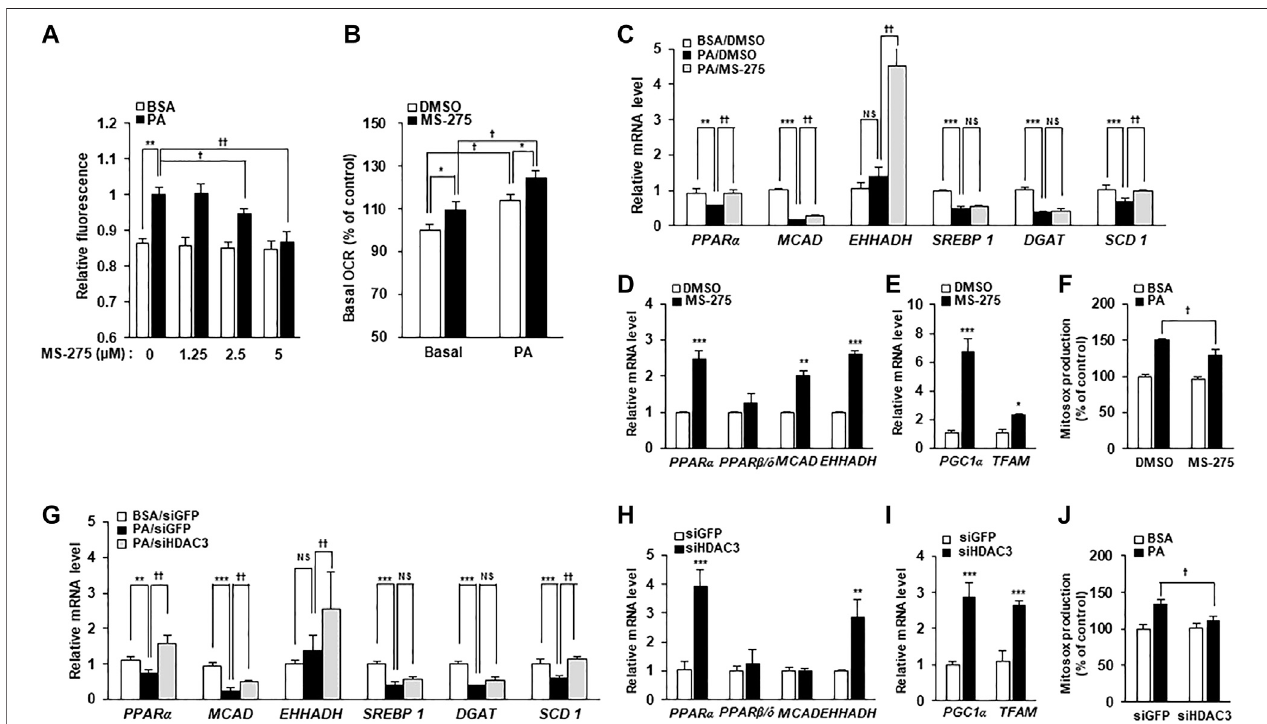
FIGURE 5 | Inhibition of HDAC3 by MS-275 or siRNA increased mitochondrial fatty acid oxidation and related gene expression. (A) C2C12 myotubes were pretreated with various concentrations of MS-275 for 16 h and then treated with 300 μ M PA for 6 h. The intracellular TG content was determined by measuring the fl uorescence of BODIPY. ** p < 0.01 vs. PA-untreated cells, † p < 0.05; †† p < 0.01 vs. PA-treated cells. (B) The OCR of PA when used as the sole carbon substrate was measuredusingtheSeahorseXFAnalyzer(Agilent).* p < 0.05vs.MS-275-untreatedcells, † p < 0.05vs.PA-untreatedcells. (C) C2C12myotubesweretreatedwith orwithout2.5 μ MMS-275inthepresenceof300 μ M PAfor12 h.Theexpressionoffattyacidmetabolism-relatedgeneswasdeterminedbyreal-timePCR.*** p < 0.001 vs.PA-untreatedcells, †† p < 0.01vs.PA-treatedcells. (D) Aftertreatmentof2.5